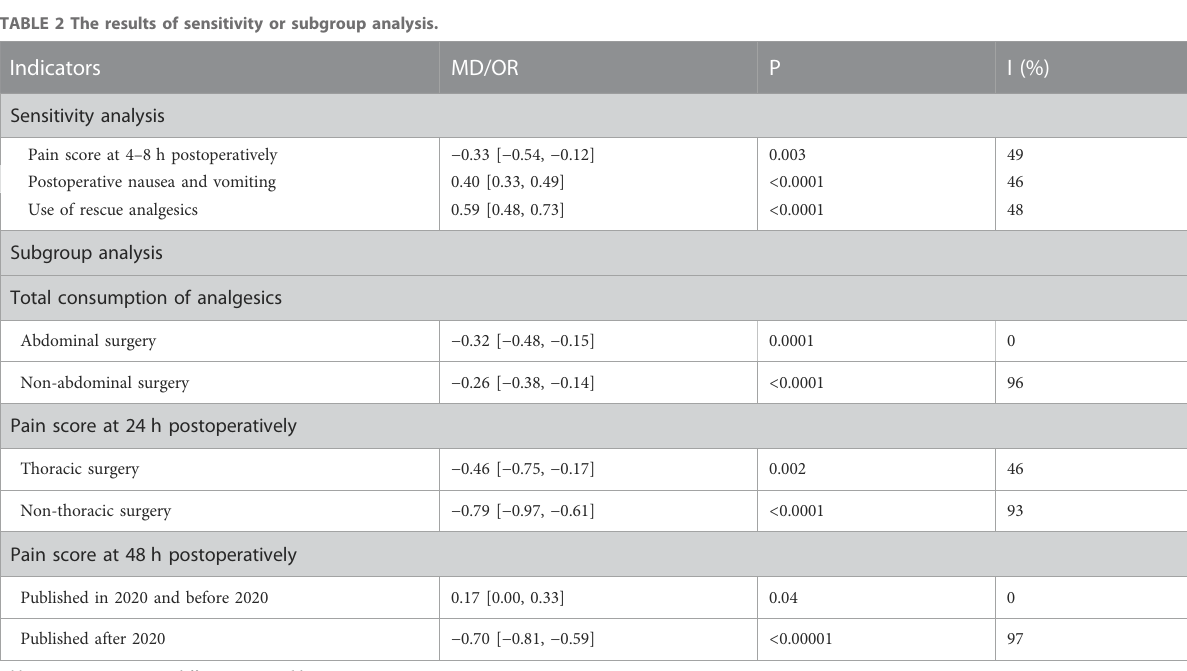
TABLE 2 The results of sensitivity or subgroup